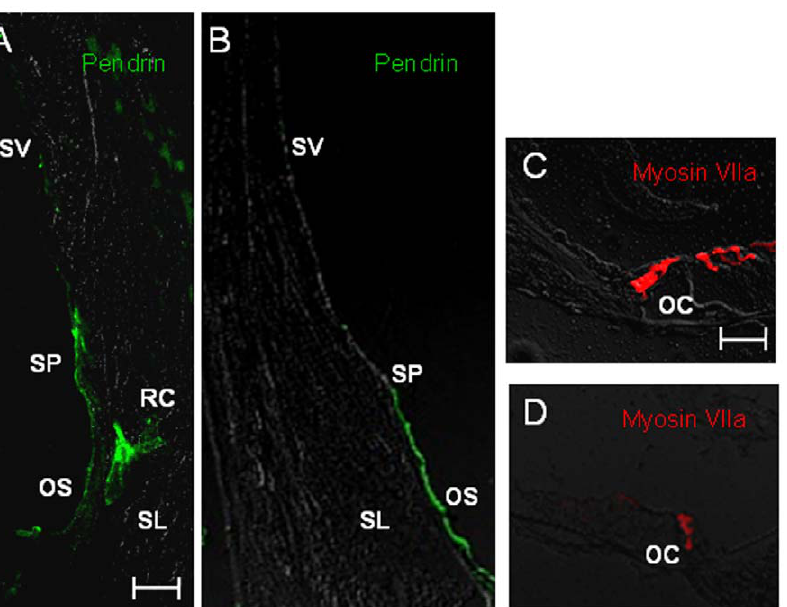
Slc26a4 tm1Dontuh/tm1Dontuh mice was revealed by fluorescence confocal microscopy (D). (OC, organ of Corti; OS, outer sulcus epithelial cells; RC, root cells; SP, spiral prominence; SL, spiral ligament; SV, stria vascularis). Bar=50 m m.